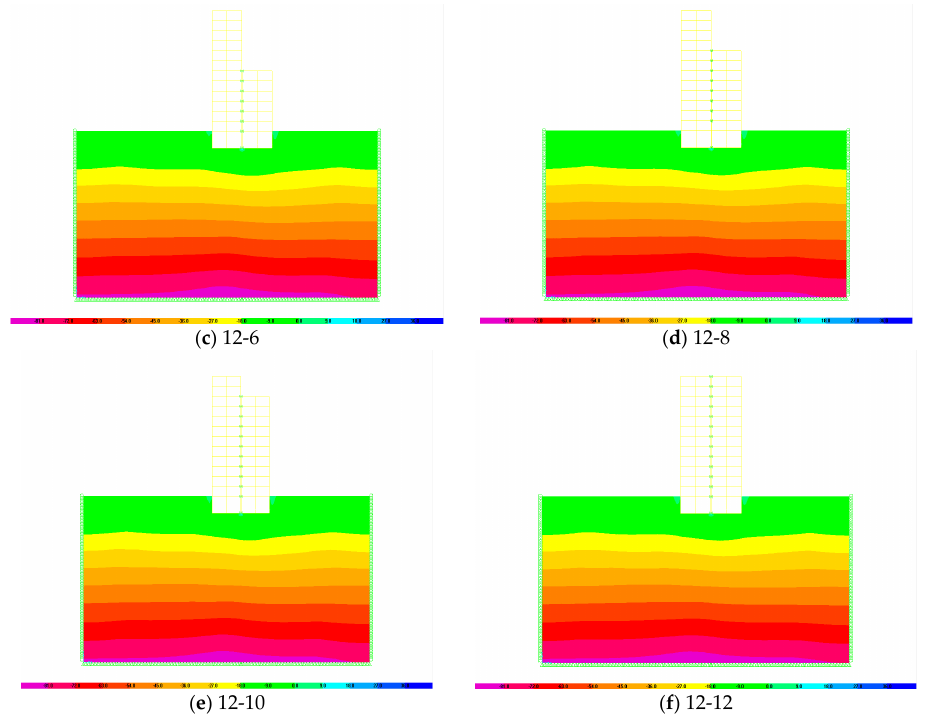
Figure 21. Vertical soil stresses (KN/m 2 ) for the two adjacent buildings with equal foundation levels.